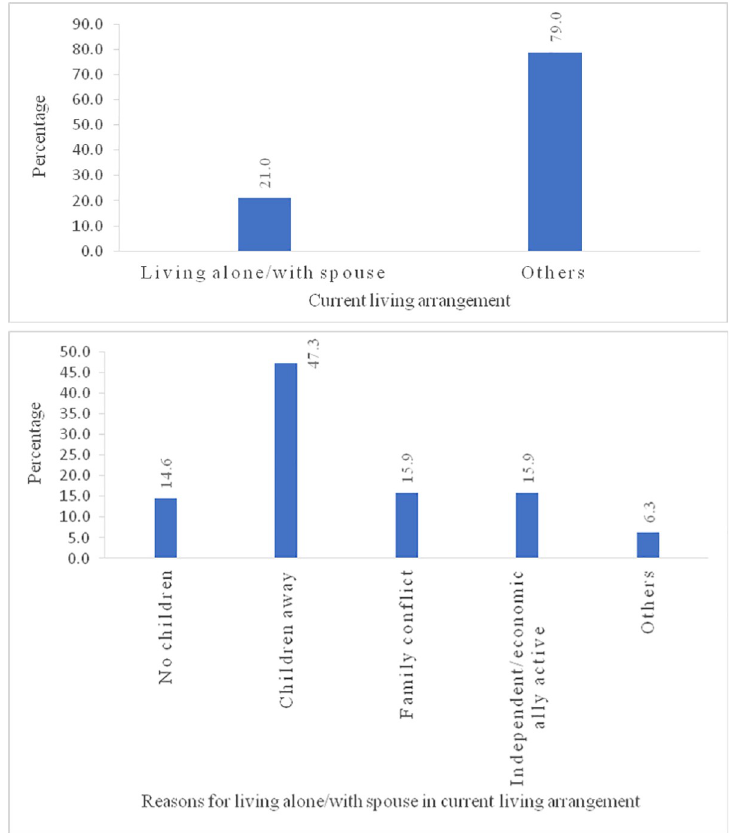
Fig 1. A. Percentage distribution of current living arrangement among older adults in India. B. Percentage distribution of reasons for living alone/ with spouse in current living arrangement.